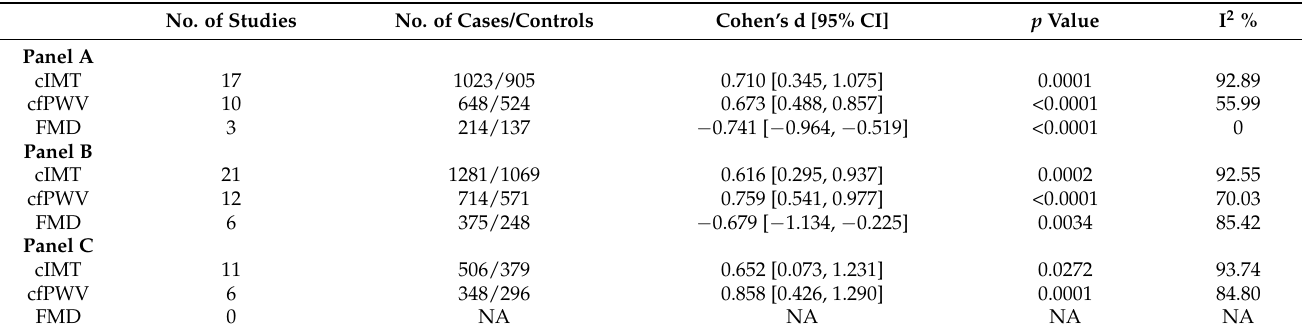
Table 2. Sensitivity analyses. Panel A: “high quality” studies (Newcastle–Ottawa Scale ≥ 7) included; Panel B: exclusion of studies reporting on the pediatric IBD; Panel C: inclusion of studies specifically reporting on patients with IBD and matched controls without traditional cardiovascular risk